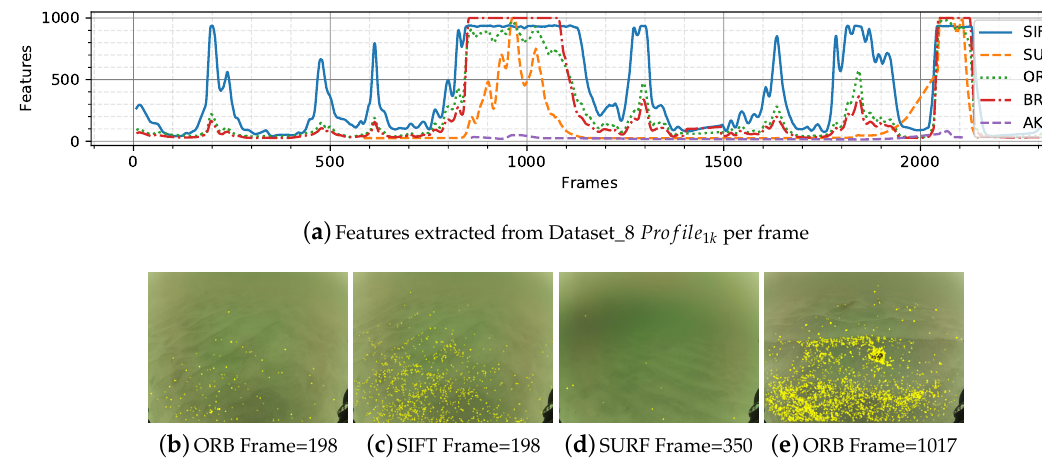
Figure 6. Detail of features extracted from Dataset_8. ( a ) features per frame. ( b – e ) extractors applied in different frames.